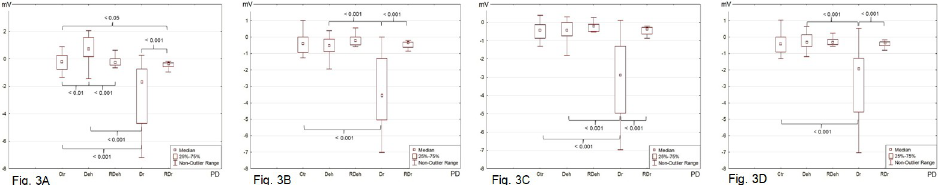
Fig 3. The transepithelial electric potential (PD, mV) measured in stationary conditions of the isolated rabbit skin specimens incubated in: ( a ) Ringer’s solution (RH); ( b ) bumetanide (0.1 mM) solution; ( c ) amiloride (0.1 mM) solution; ( d ) solution of amiloride (0.1 mM) and bumetanide (0.1 mM). The skin specimens were pre–treated as follows: Ctr (control: skin specimens incubated in RH for 30 min), Deh (dehydrated: skin specimens incubated in 10% NaCl for 30 min), RDeh (rehydrated after dehydration: skin specimens rehydrated in RH for 30 min after incubation in 10% NaCl for 30 min), Dr (dried: skin specimens dried at 37˚C for 60 min), RDr (rehydrated after drying: skin specimens rehydrated in RH for 60 min after drying at 37˚C for 60 min). The p values < 0.05 were considered as statistically